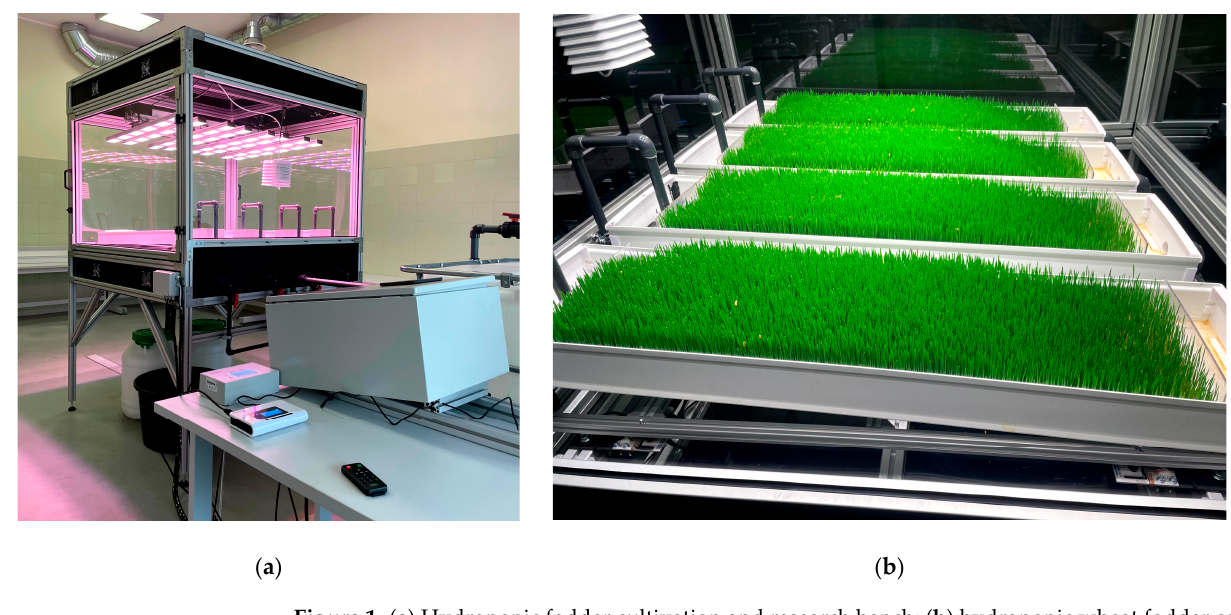
Figure 1. ( a ) Hydroponic fodder cultivation and research bench; ( b ) hydroponic wheat fodder on the sixth day of cultivation.